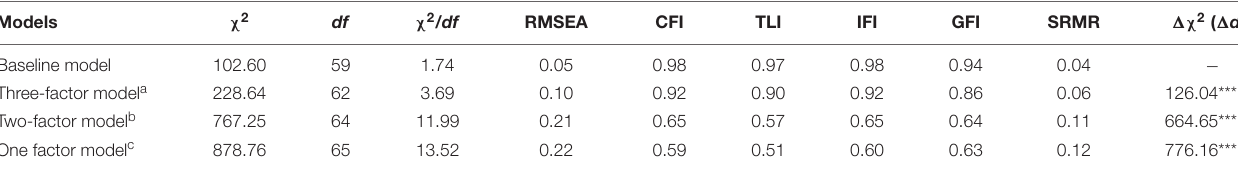
TABLE 3 | Results of CFAs: comparison of measurement models. Models